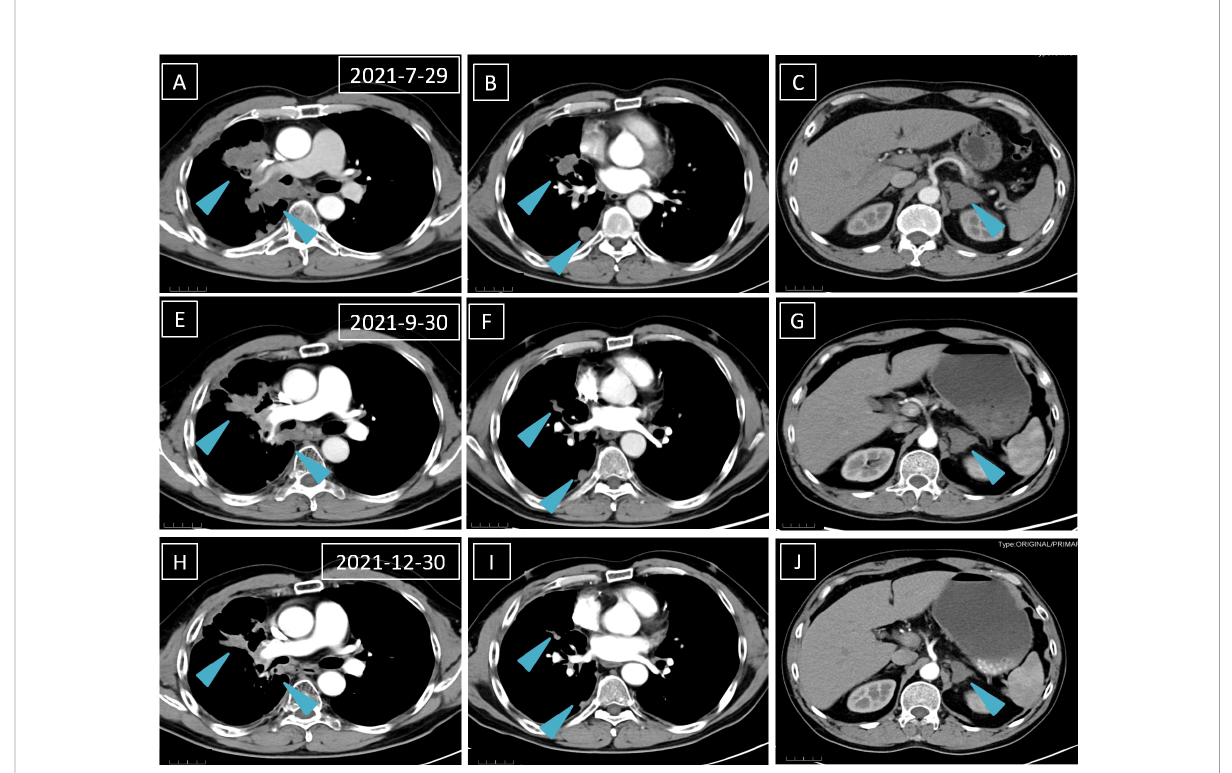
FIGURE 1 A computed tomography scan is performed before (A – C) , 1 month after (D – F) , and 4 months after (H – J) trametinib treatment. The blue arrows mean lung and left adrenal gland nodules.